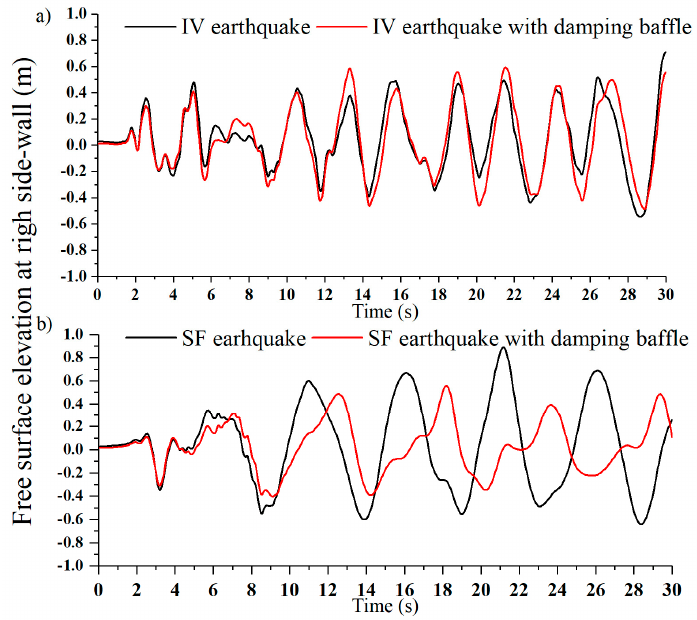
Figure 14. The suppression effect of the vertical damping baffle on sloshing water, ( a ) the free surface elevation under the Imperial Valley 1940 earthquake, ( b ) the free surface elevation under the San Fernando 1971 earthquake.